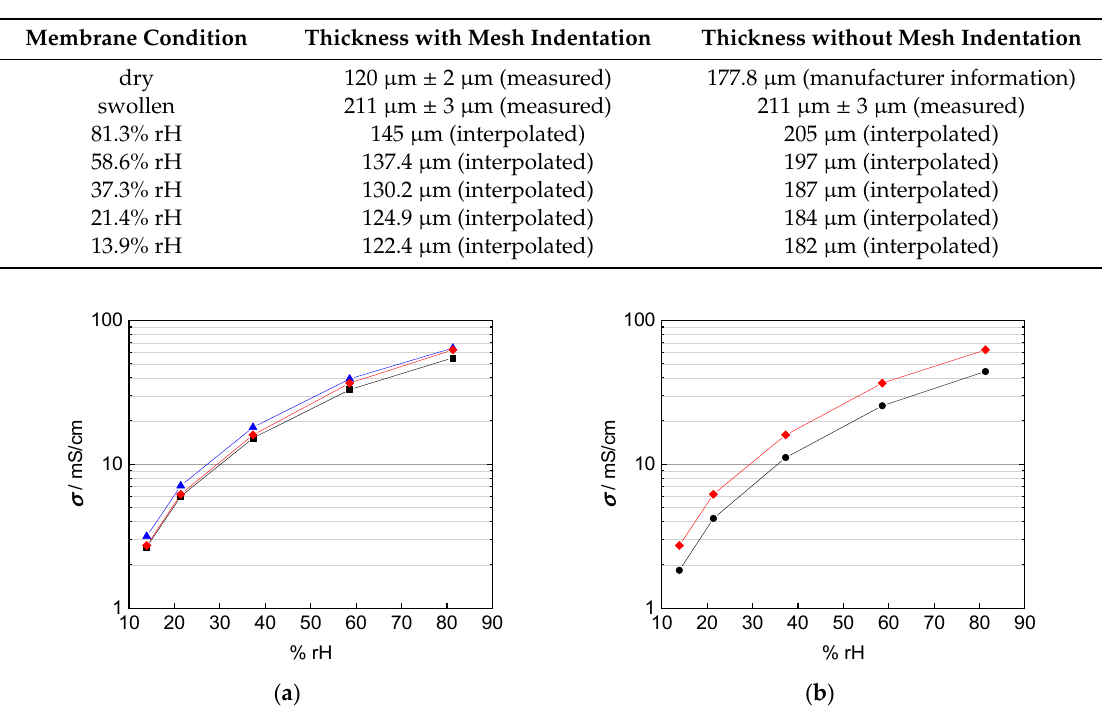
Figure 9. Calculated conductivity of Nafion 117 at 100 ◦ C with ( a ) black: thickness of dry membrane; blue: swollen thickness; red: interpolated thickness with respect to humidity; and ( b ) black: interpolated thickness with respect to humidity and mesh indentation; red: interpolated thickness with respect to